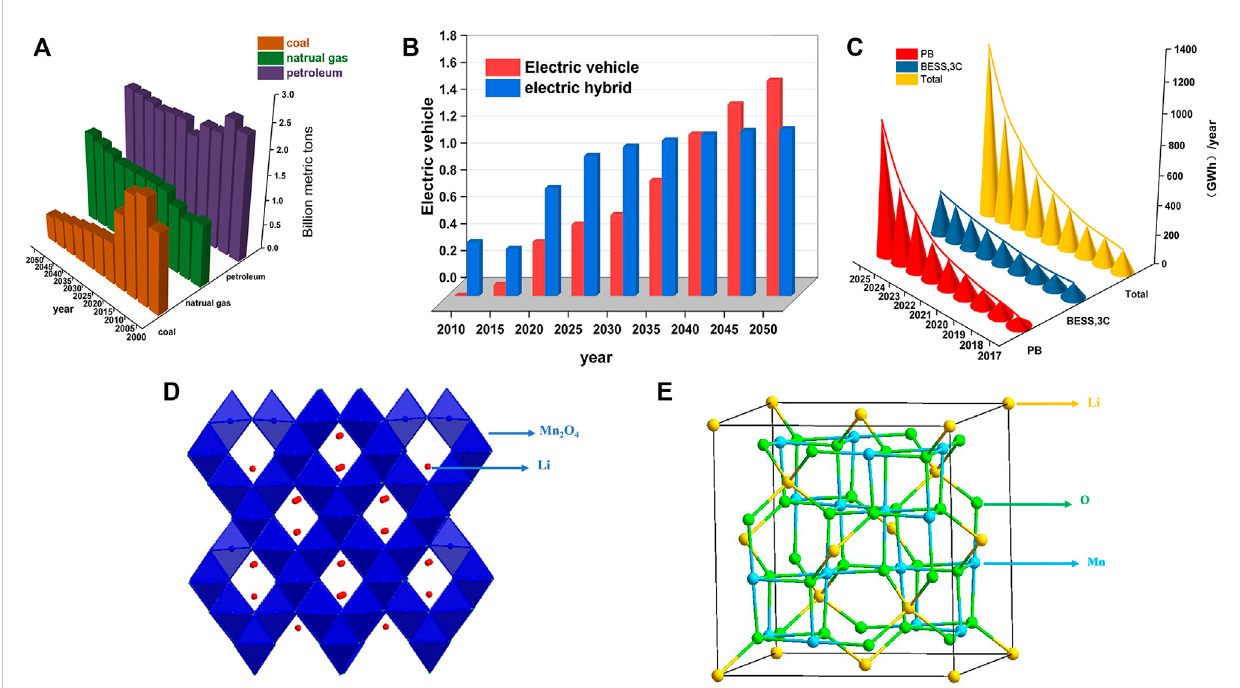
FIGURE 1 (A) CO 2 emissions from different energy fuels in different years; (B) The number of hybrid vehicles and electric vehicles of different years; (C) statistics and forecast of the installed capacity of LIBs in the world from 2017 to 2025; (D) Spinel structure of the LMO; (E) The position of Li, Mn, and O in the LMO.